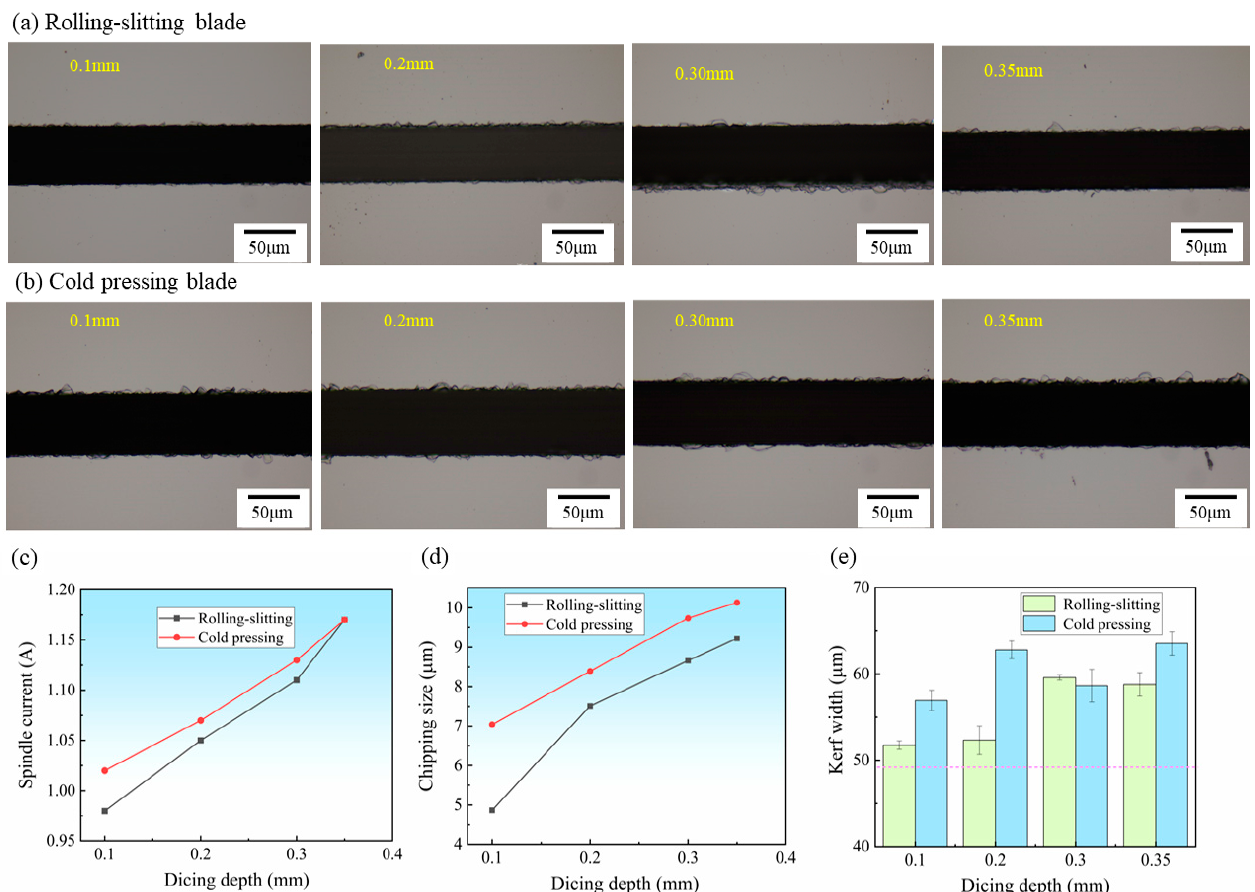
Figure 8. Result of SiC wafers diced at different dicing depth, Spindle speed n = 22,000 rpm, feed rate vf = 1 mm/s: ( a , b ) Surface morphology of SiC, ( c ) Spindle current, ( d ) Maximum chipping size, ( e ) Kerf